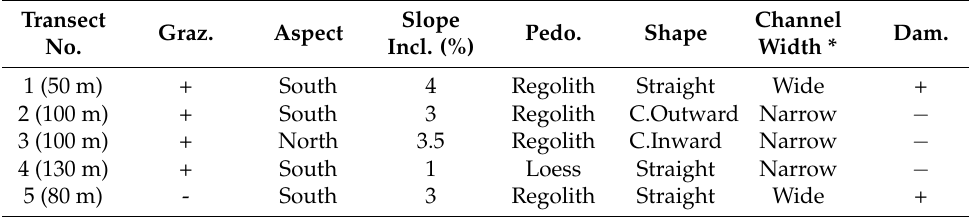
Figure 1. The location of the area of the study circle—Rahma site of study. The orange arrow shows the wadi of study (WOS) (source: Google Earth). mostly in the wadi south bank based on grazing patterns (with grazing and without—the ungrazed transect was inaccessible to the animals due to the geographic outlines of its surroundings), on different channel flow directionality, straight and curved plots. In the curved plot, the outward and inward slopes were studied separately [4] and over slopes with different pedology. The characters of the different transects are presented in Figure 2 and Table 1. Table 1. Analyzed transects over